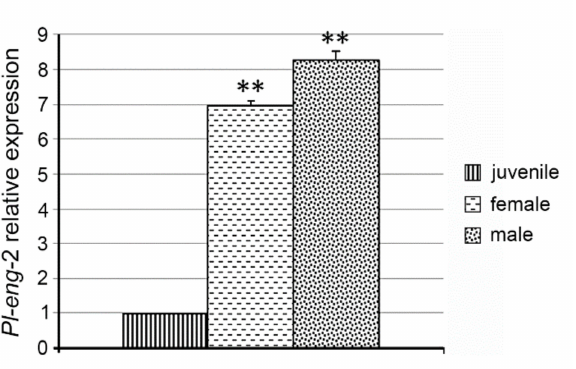
Figure 3. Expression of the Pl-eng -2 in juveniles (J2) and adult females and males. Bars indicate standard errors of the mean data ( n = 3). Significant differences were found between J2 and the adult stages (** p < 0.01).